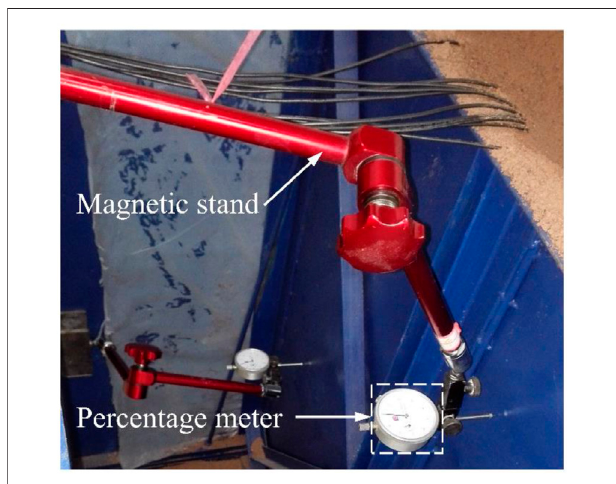
FIGURE 3 | Displacement measuring device.